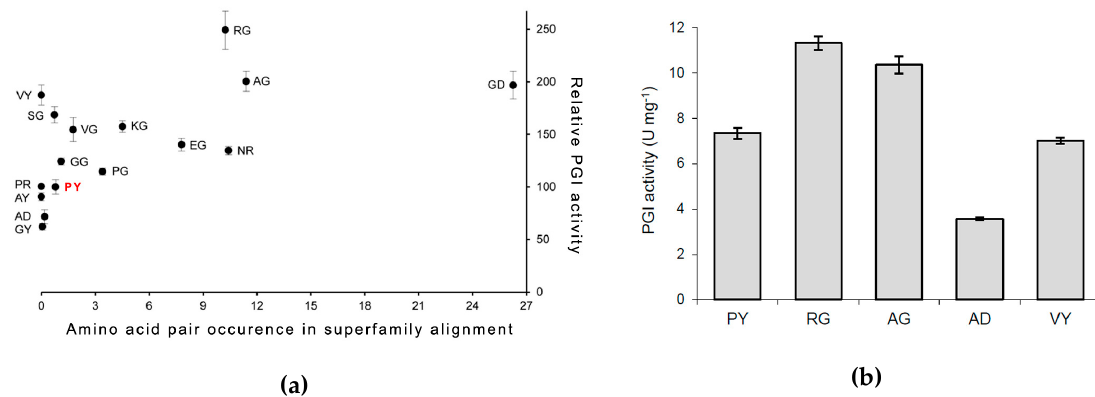
Figure 3. The results of activity measurement: ( a ) Graphical representation of the relative activity of each PfPGI mutant (Y-axis) compared to the amino acid pair occurrence according to the Comulator-based CMA predictions (X-axis). All phosphoglucose isomerase (PGI) activities are relative to wild-type P. furiosus PGI (PfPGI; PY; in red). ( b ) The specific activity of wild-type PfPGI (PY) compared to selected high-occurrence / activity mutants P132R / Y133G (RG) and P132A / Y133G (AG), and lower or similar occurrence / activity mutants P132A / Y133D (AD) and P132V (VY). Manganese was used as co-factor and added via